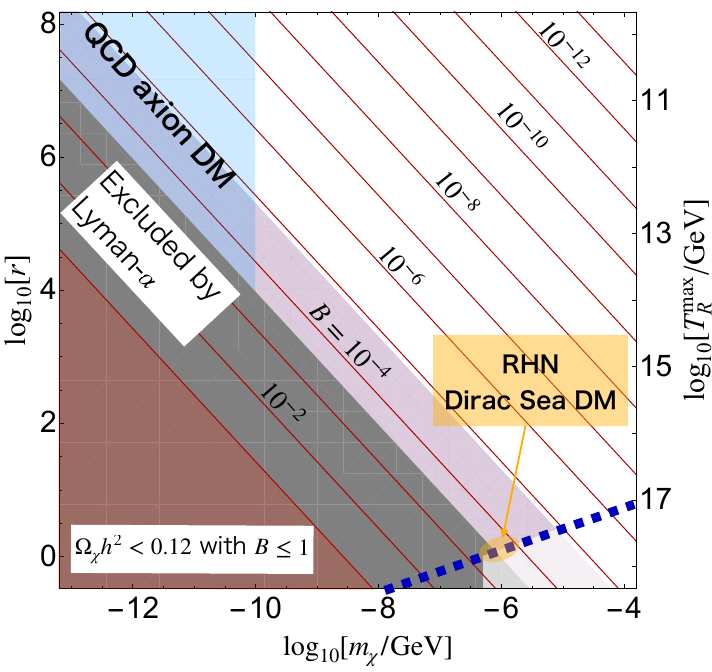
Figure 1 . The contour of constant B to realize the present DM density on m χ vs. r plane (see eq. (3.7)), taking Ω χ h 2 = 0 . 12 . The maximal possible reheating temperature as a function of r is shown on the right axis. In the gray region, the DM may be too hot to be consistent with Lyman- α forest data by assuming that the DM momenta at t = t R is typically m φ / 2 . The purple region may be tested in the future. For the case of the Fermionic DM, only the region below the blue-dotted line is relevant because of the Pauli-blocking (see section 3.2). The typical parameter range of QCD axion DM and right-handed neutrino DM are shown in light blue and orange (see section